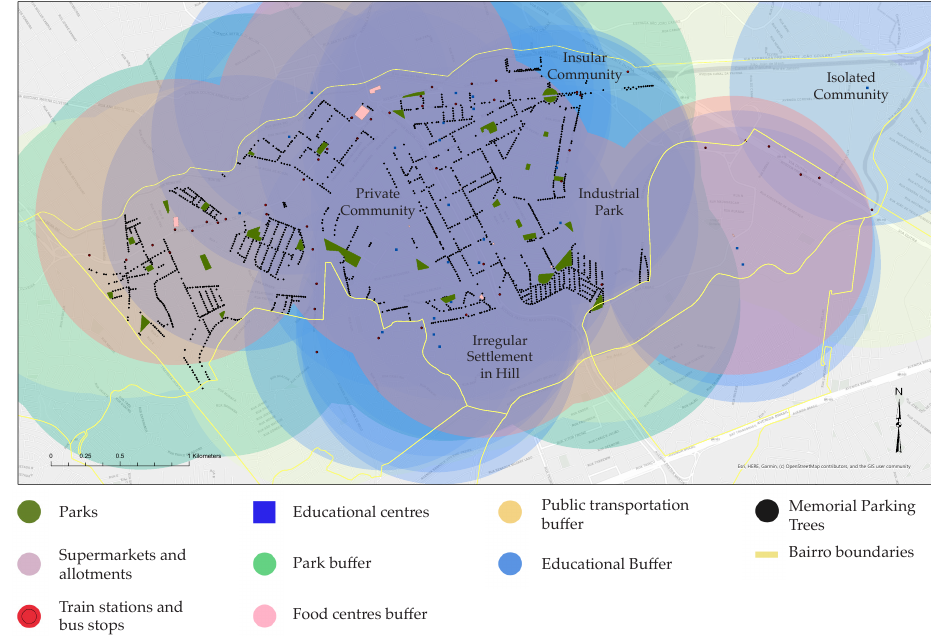
Figure 7. A total of 1904 MPT spots were identified within the neighbourhood.